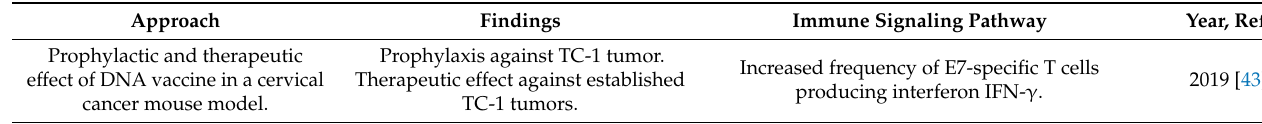
Table 1. Preclinical studies with the adjuvant